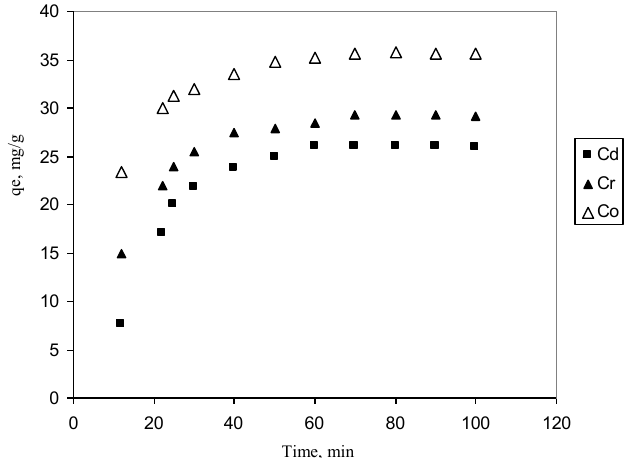
Figure 3 . ACOP contact time effect on Cr 3+ , Cd 2+ , and Co 2+ removal. Conditions: C 25 mg∙L –1 ; ACOP dose, 0.02 g; pH 5.0 and temperature, 298